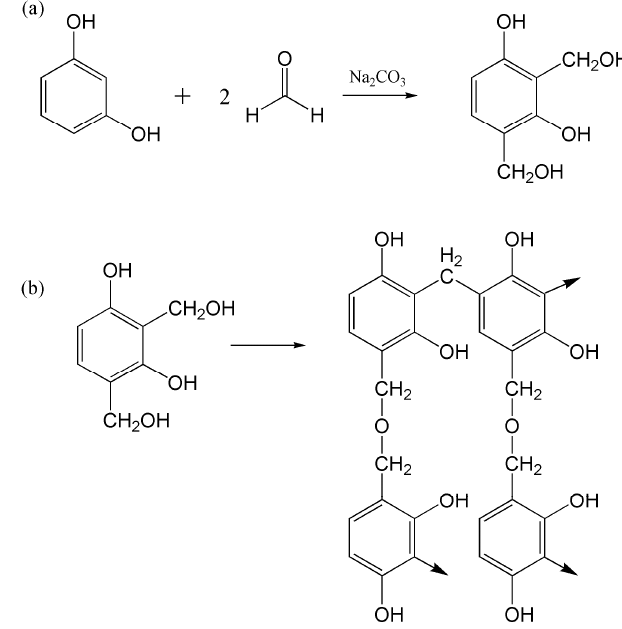
Figure 2. Reaction schematic of RF ( a ) addition reaction and ( b ) polycondensation.